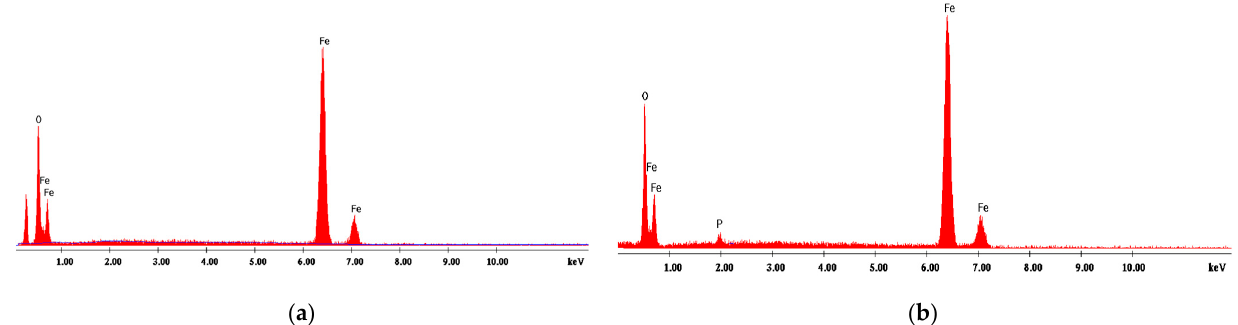
Figure 1. EDX analysis of magnetite ( a ) before and ( b ) after phosphorus adsorption.